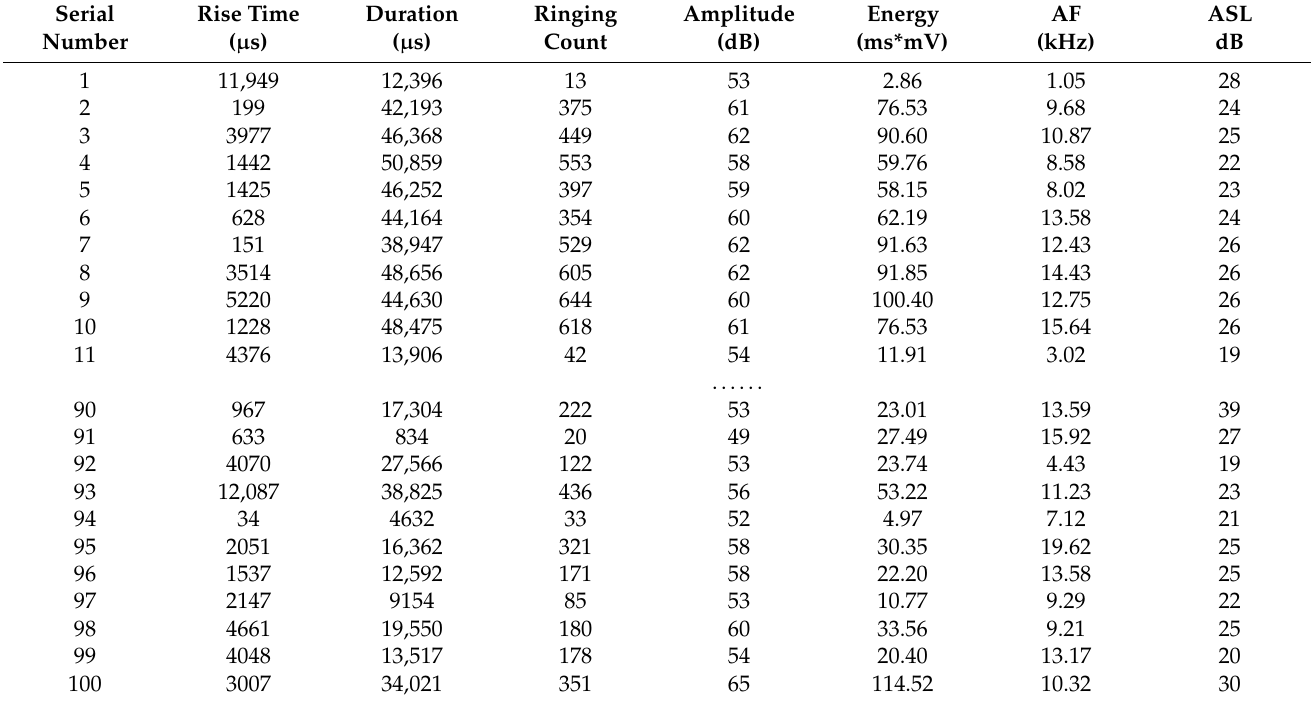
Table 1. Noise signal characteristics parameters